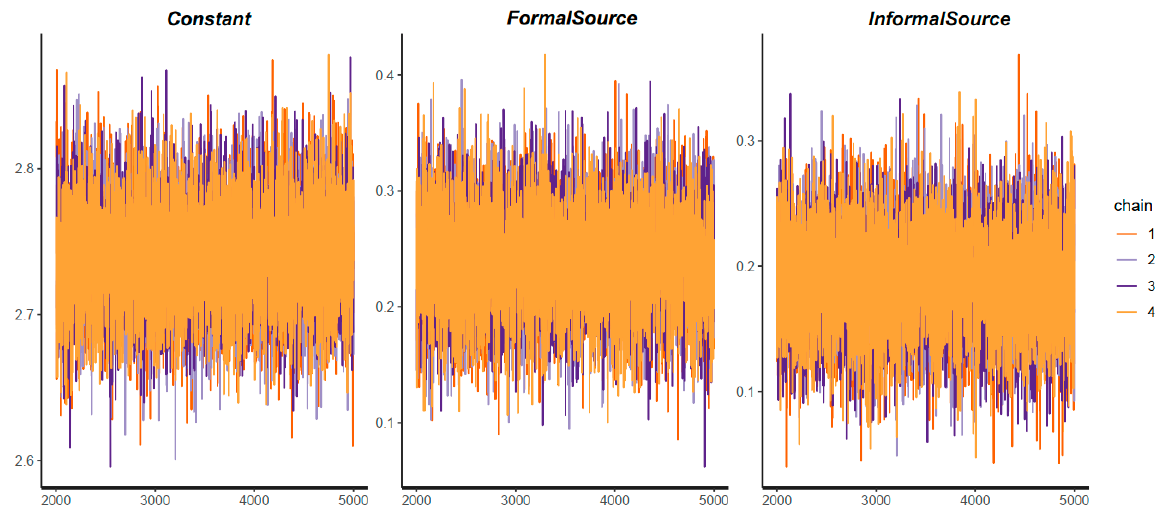
Figure 4. Model 2 ′ s PSIS diagnostic plot.